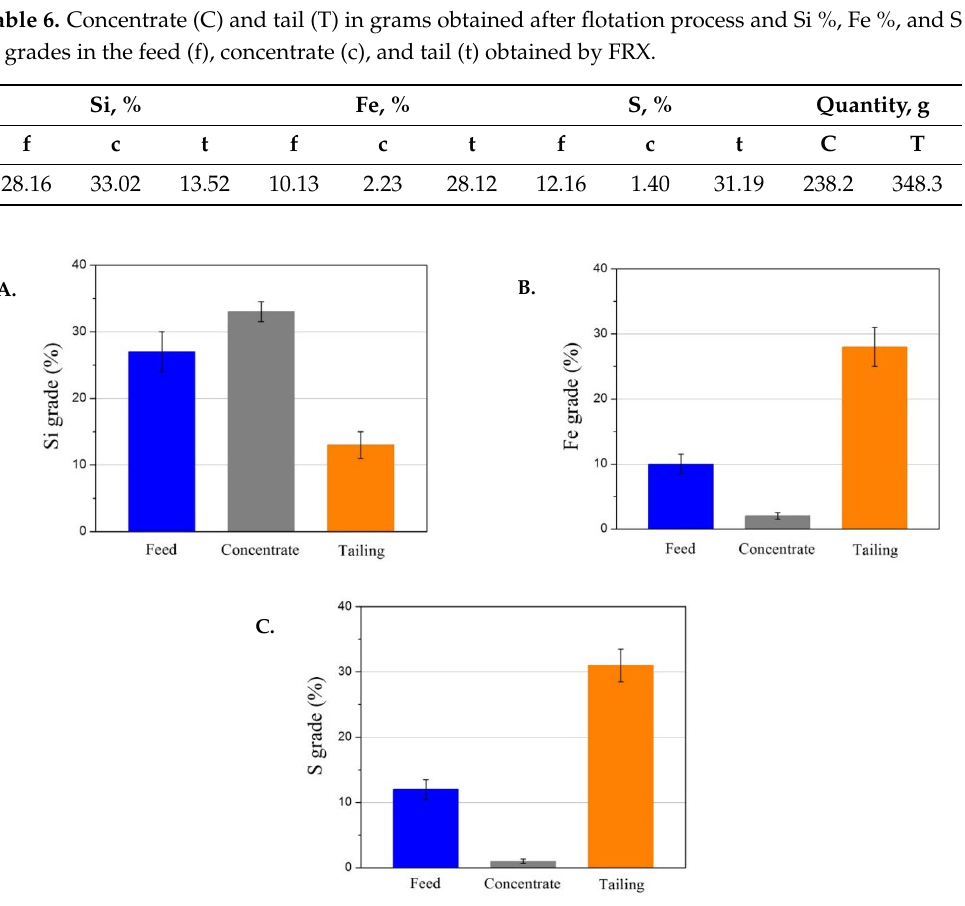
Figure 4. Comparative plot of the grades of Si ( A ), Fe ( B ), and S ( C ) present in the different stages of the flotation process.